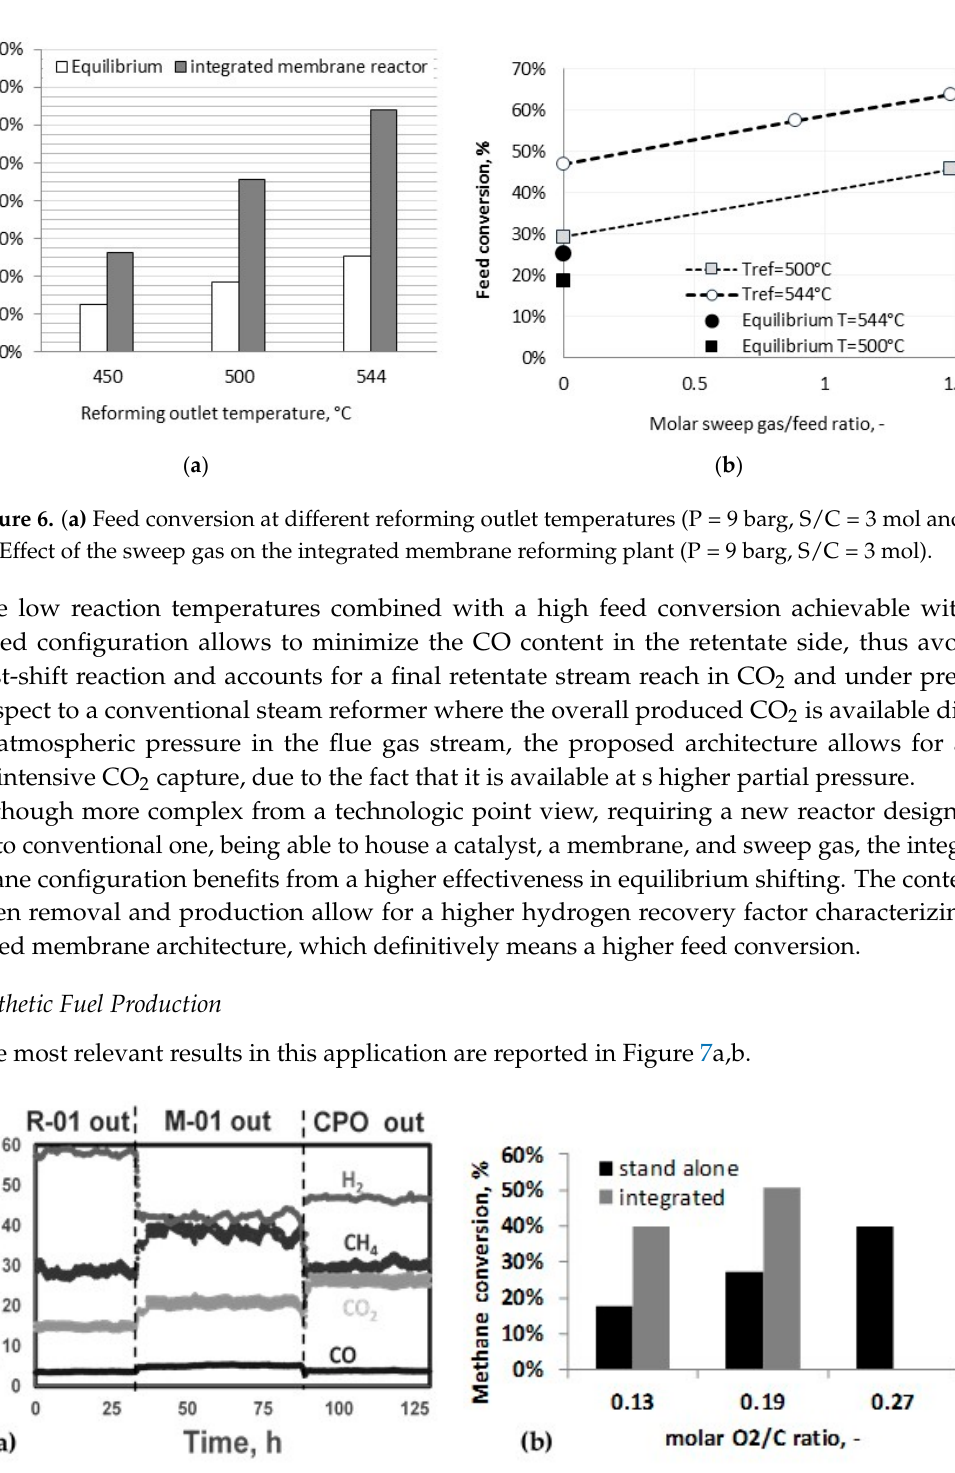
Figure 7. Performance of the membrane-based GTL process: ( a ) Stability, ( b ) Oxygen consumption.